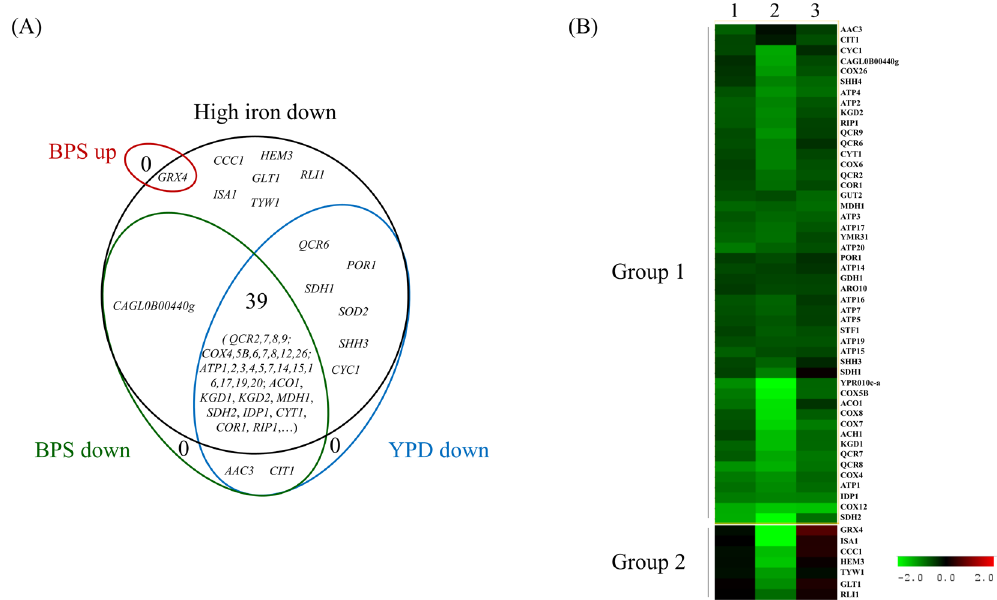
Figure 2. Transcriptome analyses of Hap5 impact on gene expression. The wild type and hap5 Δ strains were grown in three different conditions (rich media, iron excess or iron starvation) and their transcriptomes were compared using microarrays. ( A ) Venn diagram representing the overlaps between the lists of Hap5 ChIP targets being significantly down regulated compared with wild type in YPD (blue line), BPS (green line) or iron excess (black line). The red line includes the only Hap5 ChIP target ( GRX4 ) which was significantly up-regulated upon BPS treatment. The gene names are from the S. cerevisiae orthologs, when available. ( B ) Eisengram of the expression profiles of the genes from the Venn diagram. The values used are log2 of hap5 Δ / wild type expression ratios. The color scale is indicated. The conditions used are 1 : YPD; 2 : iron excess (2 mM FeSO4 for 30 minutes); 3 : iron starvation (0.5 mM BPS for 30